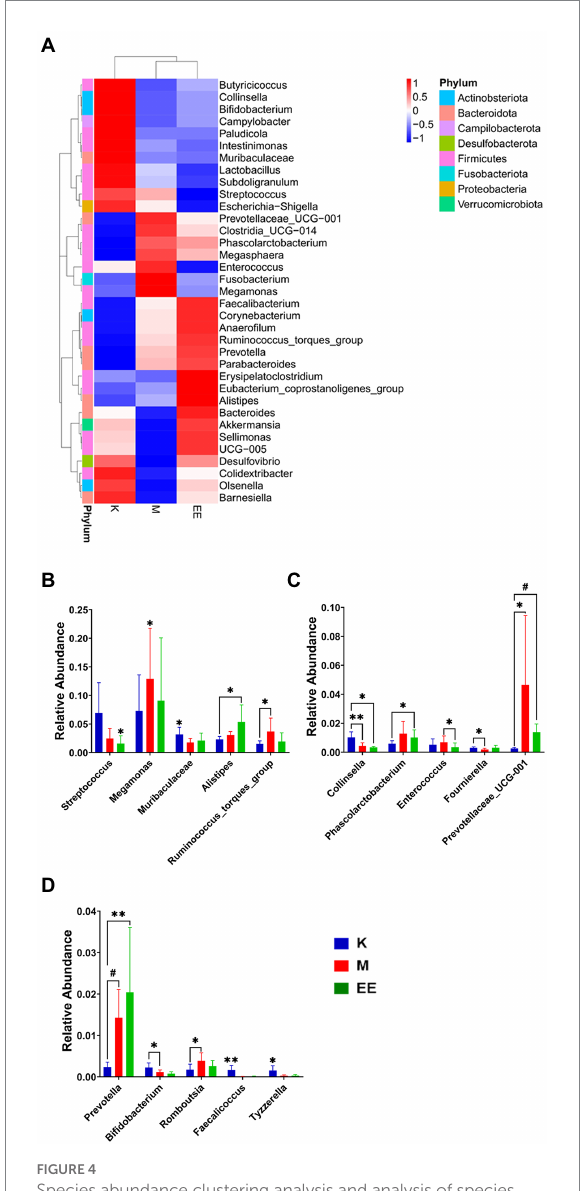
FIGURE 4 Species abundance clustering analysis and analysis of species differences between groups. (A) Clusters of species abundance in the top 35 relative abundances at the genus level; (B–D) Histograms of species abundance with significant differences between groups (top 15). N = 5, p < 0.05 (*), p < 0.01 (**), p < 0.001